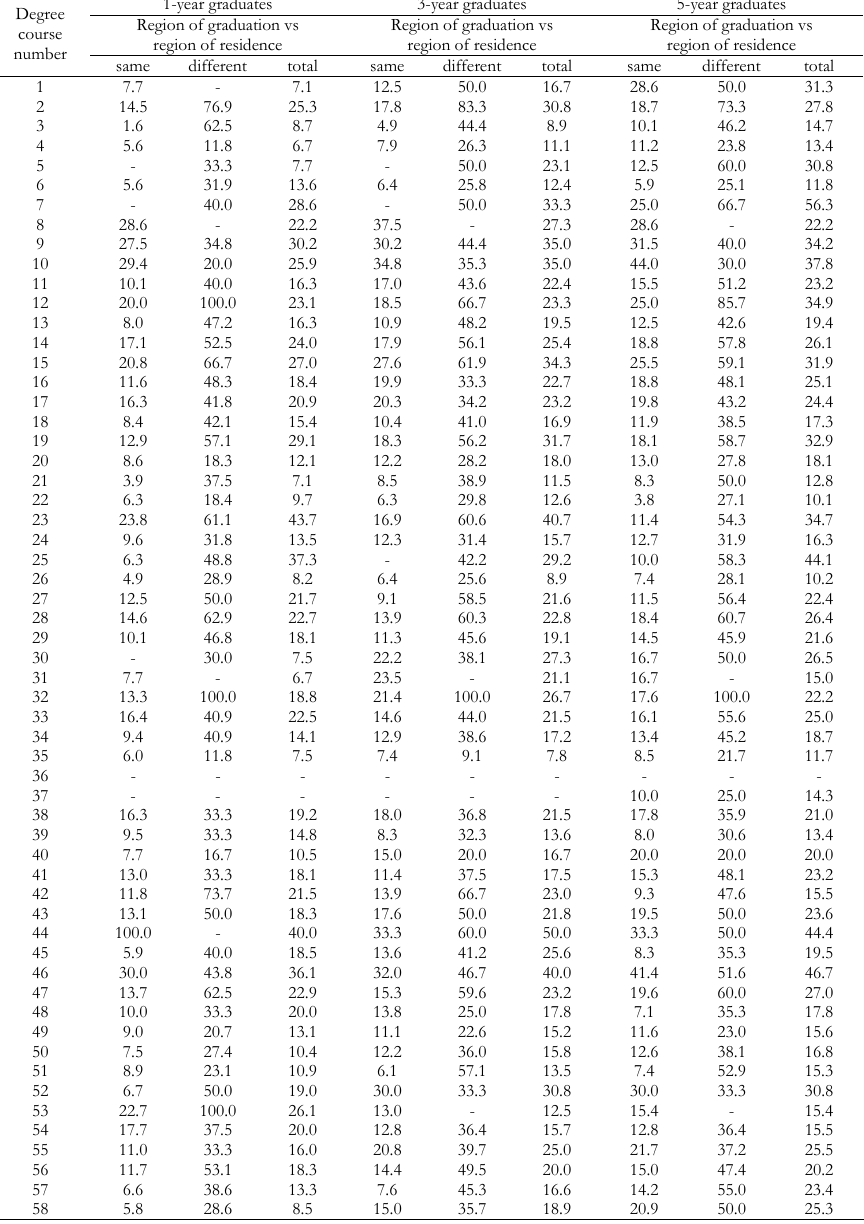
Percentage of graduates employed in a region different from the one of residence, by type of degree course and by comparison between region of graduation and region of residence: same region, different region and total number of employed graduates (degree courses denominations as per Table 1